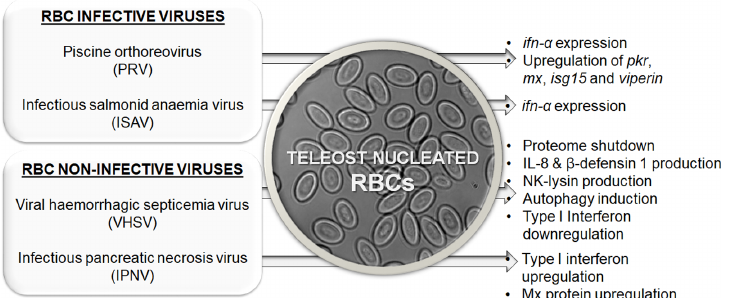
Fig 1. Schematic representation of teleost nucleated RBC immune responses against different infective (target: RBCs) or noninfective (target: other cell types) viral pathogens. ifn- α , interferon- α ; IL-8, interleukin-8; isg15 , interferon-stimulated gene 15; mx , myxovirus resistance gene; pkr , protein kinase RNA-activated; RBC, red blood cell.